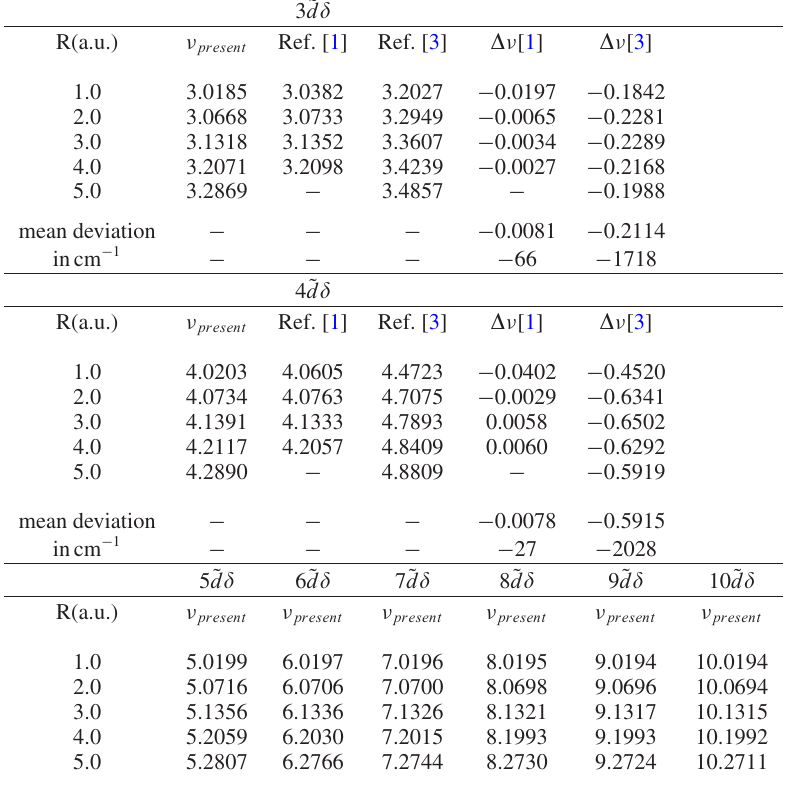
Table 1. Comparison of calculated effective quantum numbers for 1 (cid:1) n ˜ d (cid:5) states of HeH + with those from Refs. [1] and